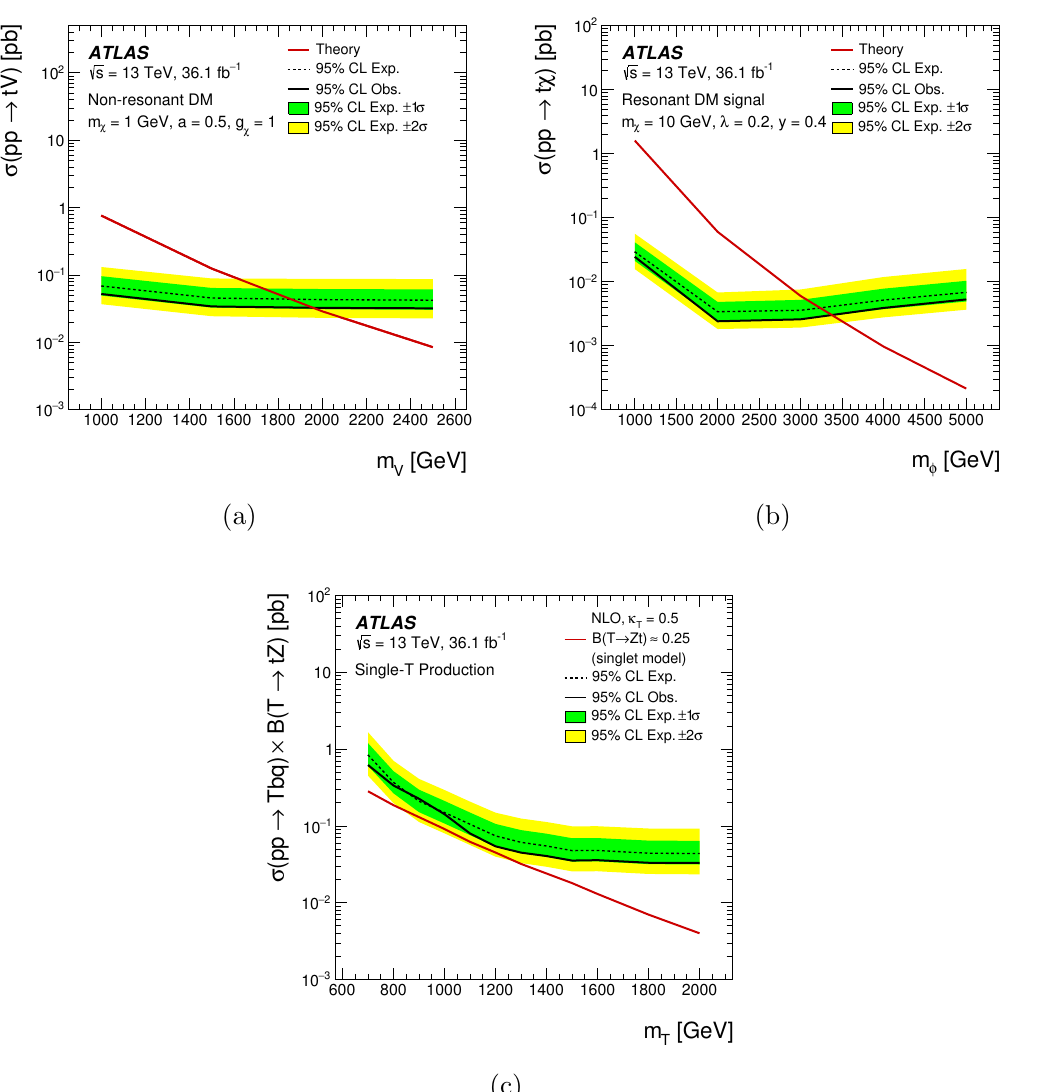
Figure 4 . 95% CL upper limits on the signal cross-section as a function of (a) the V mass in the non-resonant (NR) model, (b) the mass of the scalar particle (cid:30) in the resonant (R) model and (c) the VLT mass. LO values for the production cross-section were computed for the non-resonant (resonant) DM production modes assuming m (cid:31) = 1 GeV, a = 0 : 5 and g (cid:31) = 1 ( m (cid:31) = 10 GeV, (cid:21) = 0 : 2 and y = 0 : 4).